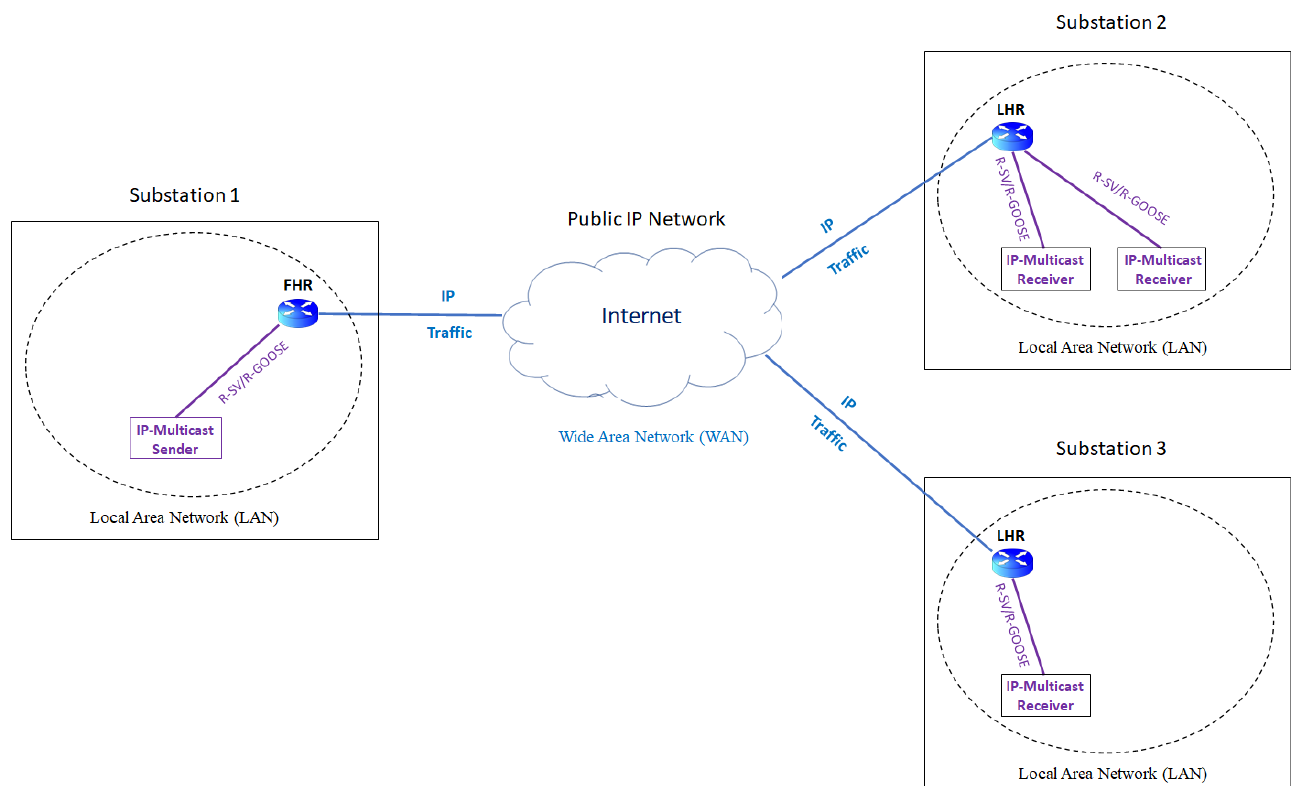
Figure 6. IP-Multicast communication from Substation 1 to Substation 2 and 3 via public IP net- work.